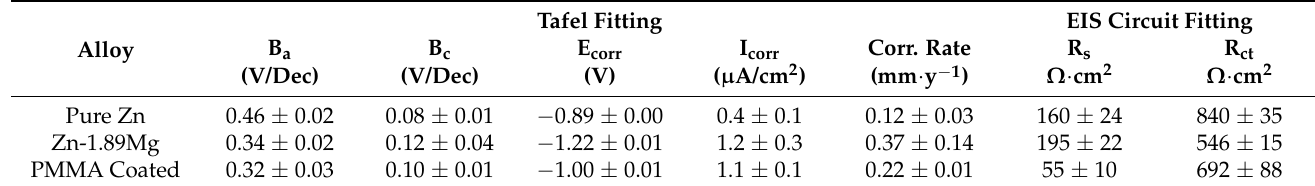
Table 1. The potentiodynamic parameters extracted from the Tafel and EIS circuits